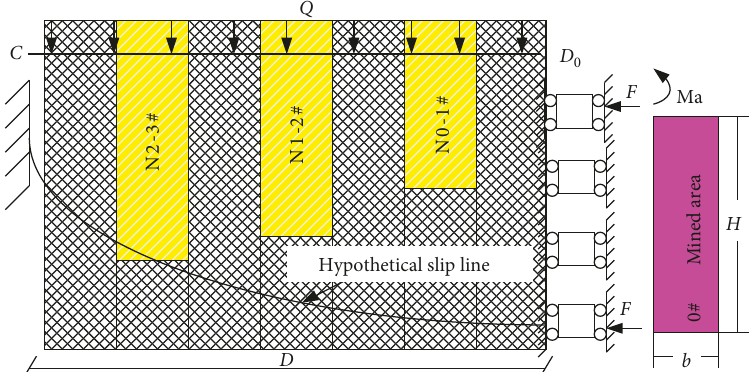
Figure 3: Mechanics model of the collapse region slip line.